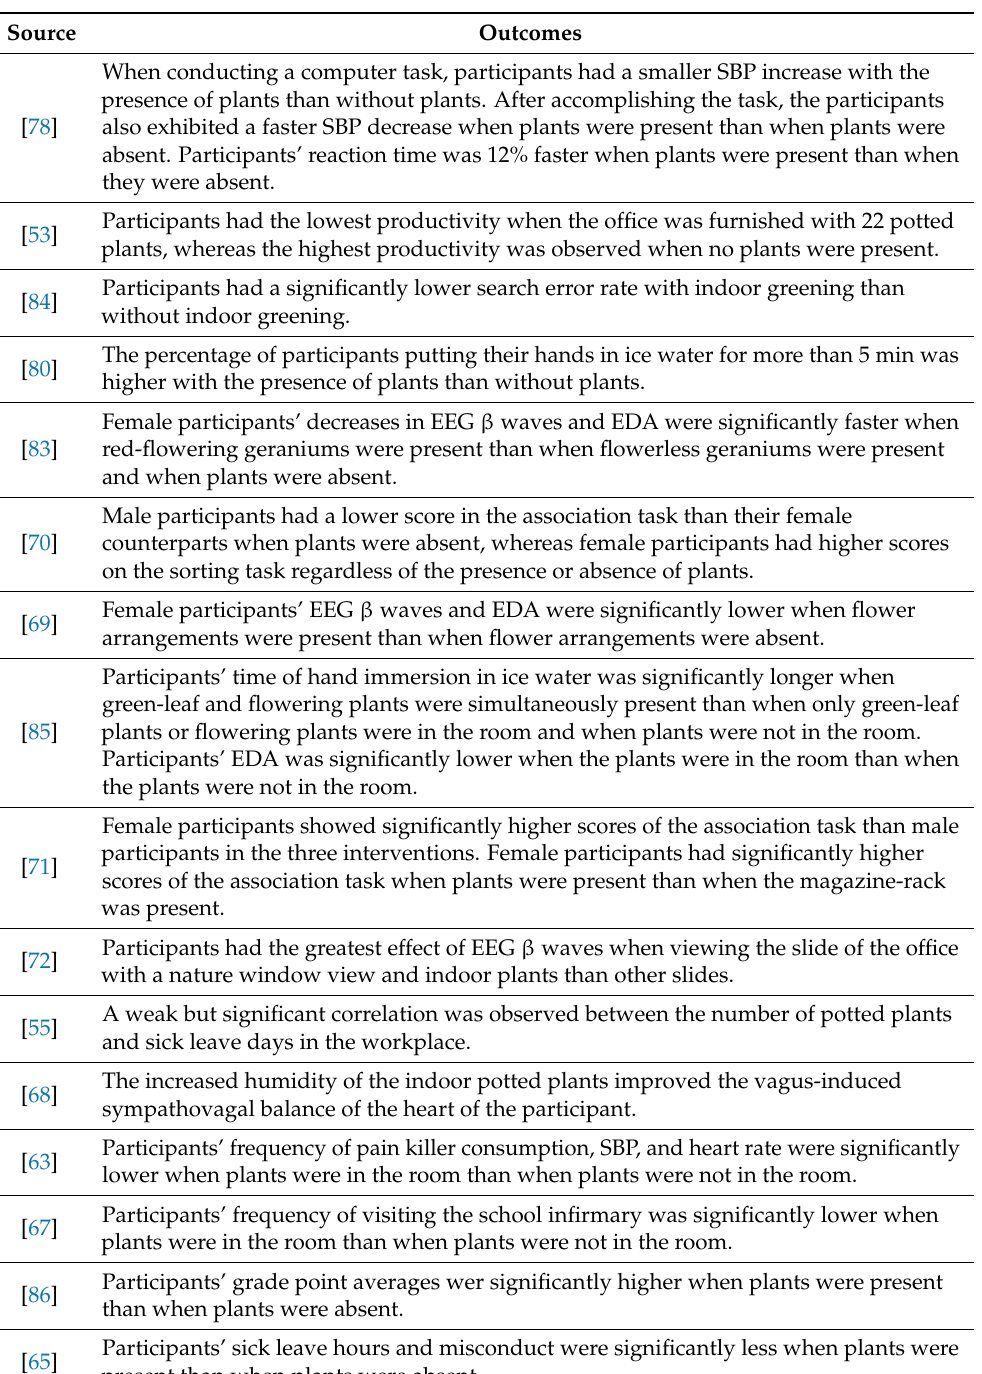
Table 7. Summary of the outcomes of the records.